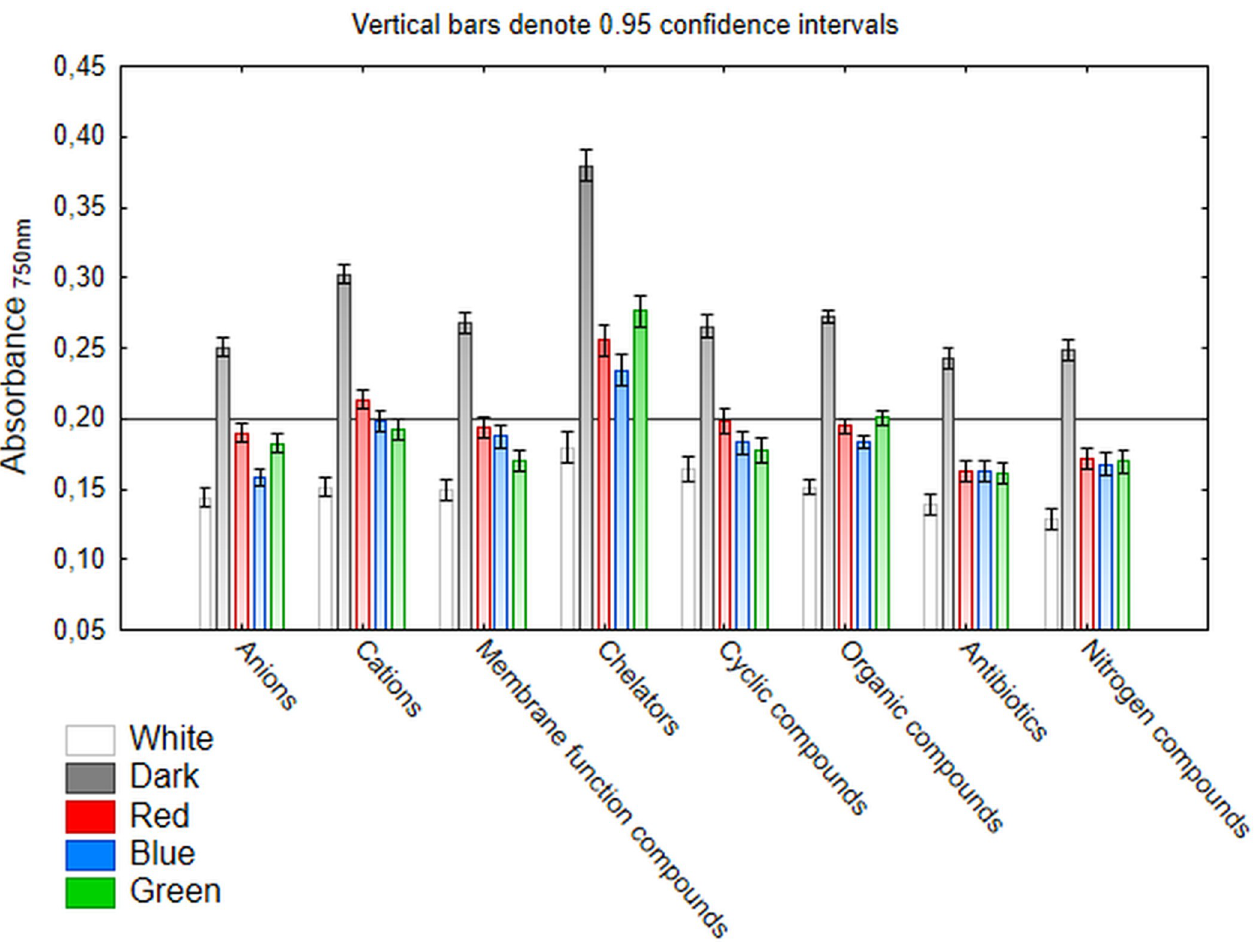
Fig 6. C . unicolor growth in different lighting treatments (white, red, blue and, green light, darkness) in the presence of various groups of potentially toxic chemical compounds. The scale represents growth values (OD 750 nm) after 10 days of incubation. The horizontal line at a value of 0.2 represents the growth threshold considered